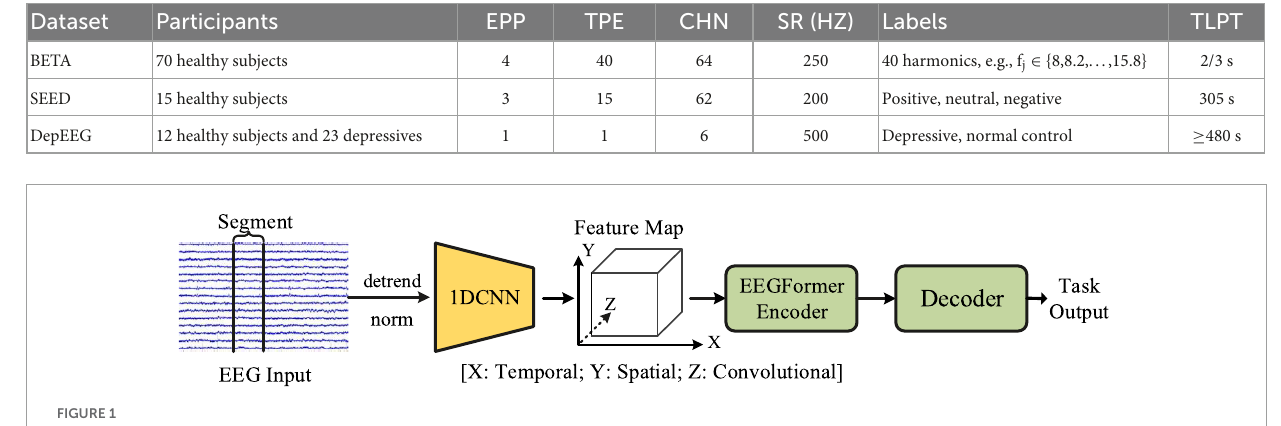
EEG segment represented using a two-dimensional (2D) matrix of size S × L , where S represents the number of EEG channels, and L represents the segment length. The EEG segment is de-trend and normalized before being fed into the 1DCNN module, and the normalized EEG segment is represented by x ∈ R S × L . The 1DCNN adopts multiple depth-wise convolutions to extract EEG-channel- wise features and generate 3D feature maps. It shifts across the data along the EEG channel dimension for each depth-wise convolution and generates a 2D feature matrix of size S × L f , where L f is the length of the extracted feature vector. The output of the 1DCNN module is a 3D feature matrix of size S × C × L e , where C is the number of depth-wise convolutional kernels used in the last layer of the 1DCNN module, L e is the features length outputted by the last layer of the 1DCNN module. More specifically,